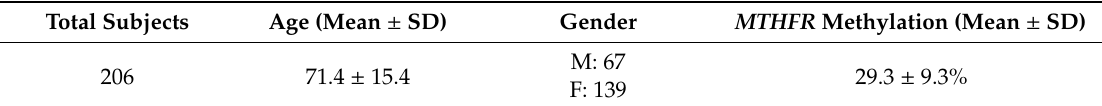
Table 1. Study population.